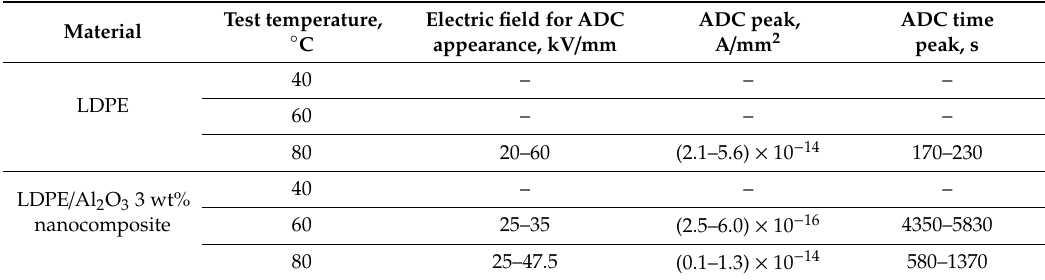
Table 2. Test conditions for anomalous discharge current (ADC) appearance and ADC parameters – current peak and time peak. Lack of data filled in the table means no ADC